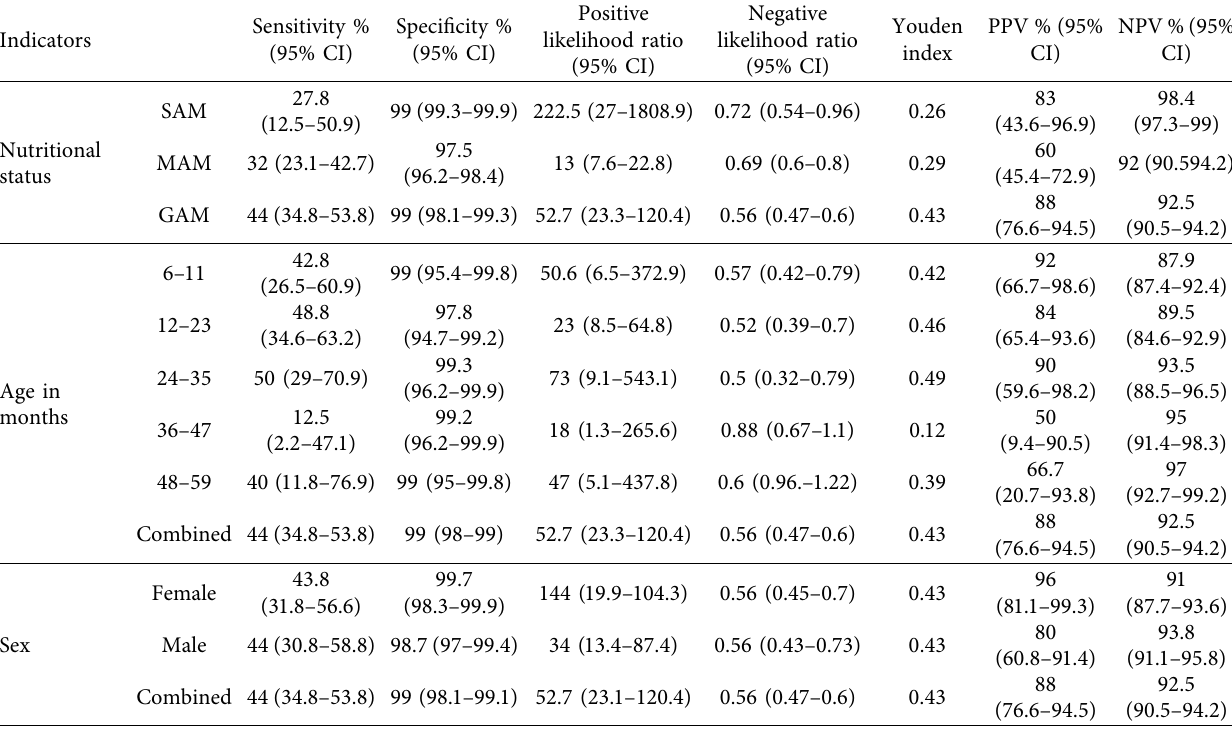
Table 4: Validity tests on RUAC using MUAC measurement as the golden standard in 6–59-month-old children from Lanfro District, SNNPR, Southern Ethiopia, 2016 ( n � 819).